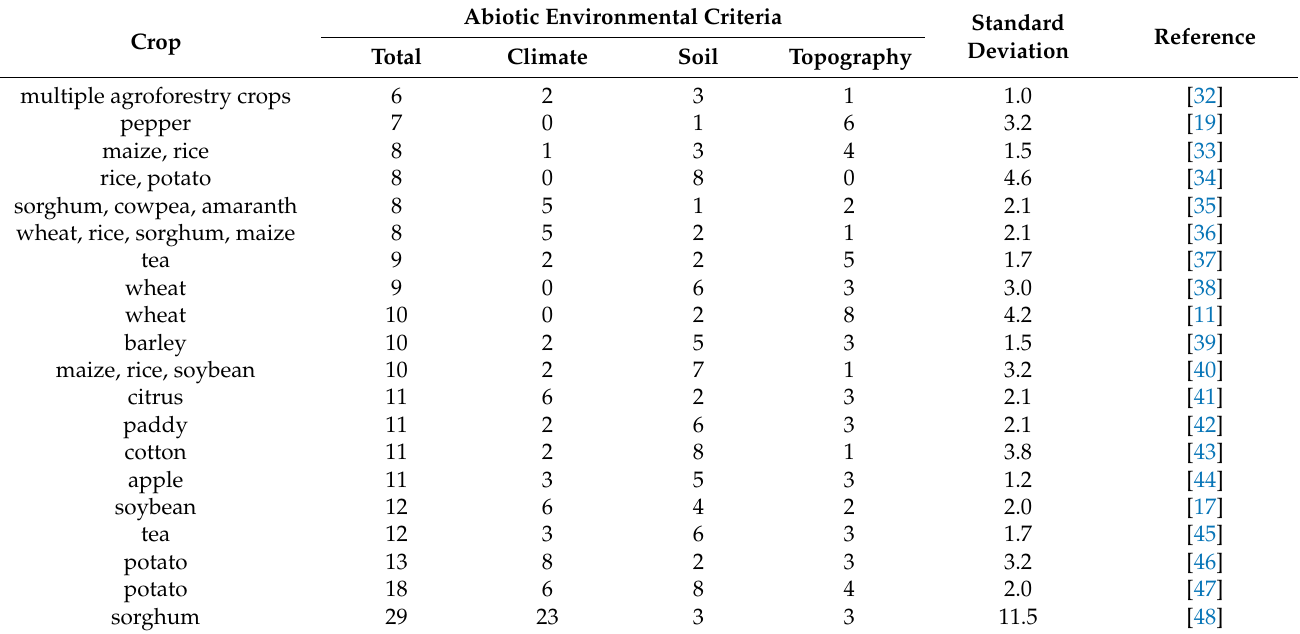
Table 1. Distribution of the three main criteria groups in previous studies for determining cropland suitability using the conventional GIS-based multicriteria